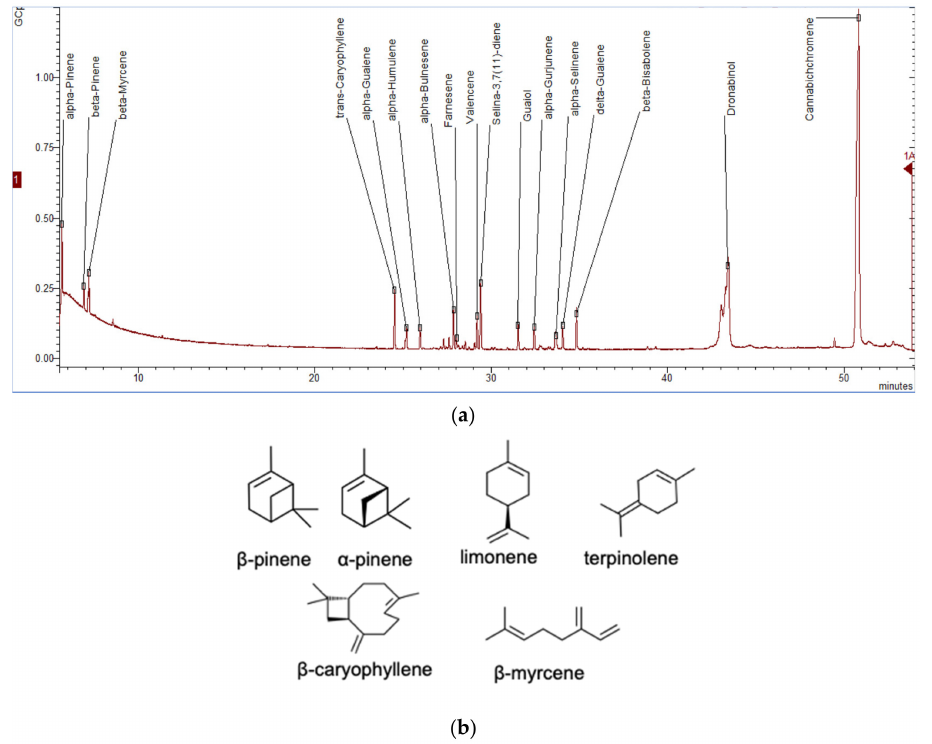
Figure 5. The gas chromatogram equipped with mass spectrometry (GC-MS) of the cannabis terpene extract (butanol) from the floral tissue of Cannabis sativa L. ( a ) and predominant terpene chemovars ( b ). Denotes the dried cannabis flower (0.2 g) extracted with propanol by the ultrasonic assisted method [36] and gas chromatography mass spectrometry (GC-MS) analysis was performed using the protocol described previously